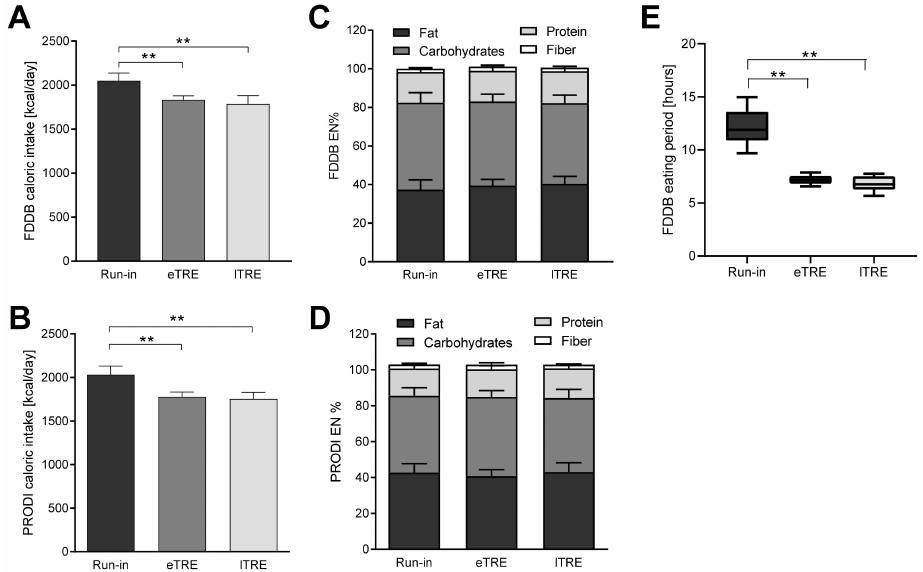
Figure 1. Energy and macronutrient intakes and eating time windows in the trial: Food record analysis was conducted using the FDDB and PRODI ® tools for energy intake ( A , B ), macronutrient intake (EN%, C , D ), and meal timing ( E ) at baseline and during both periods of the time-restricted eating (eTRE and lTRE). EN%, percentage of total energy intake; eTRE, early time-restricted eating; lTRE, late time-restricted eating; ** p ≤